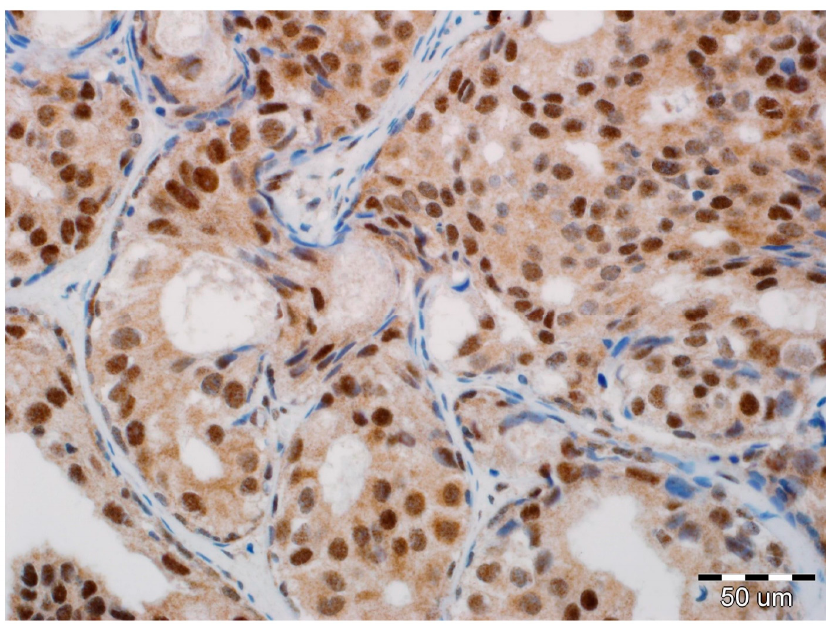
Figure 2. Positive expression of N-cadherin in luminal epithelial cells of ductal carcinoma in situ (DCIS). No reaction in stromal fibroblasts and myoepithelial cells (hematoxylin, ×400). Details of the immunohistochemistry of SPARC and Snail1 have been presented elsewhere [11,12]. For both, a semiquantitative method was used to evaluate the expression as negative (0, no staining), weak (1, either diffuse weak staining or strong staining in <10% of analyzed cells), intermediate (2, either diffuse intermediate staining or strong staining in ≥ 10% to 30% of analyzed cells), and strong (3, defined as strong staining of >30% of analyzed cells). Strong expression of Snail1 and SPARC in DCIS luminal epithelial cells is presented in Figures 3 and 4, respectively.